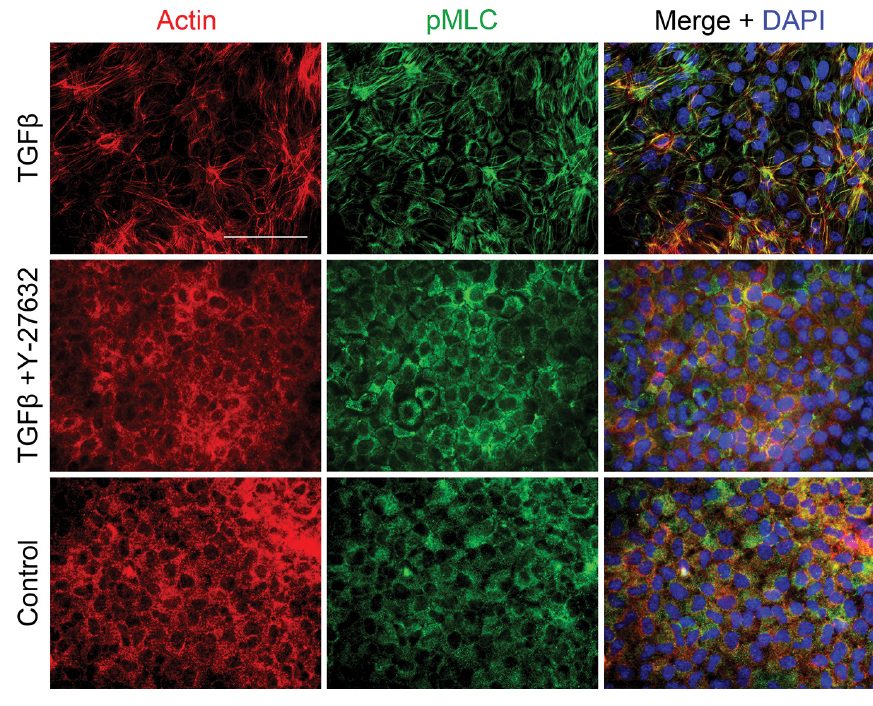
Figure 1. Y-27632 prevents TGF β -induced actomyosin contractility. Lens explants were treated with TGF β (4 ng/mL) in the presence and absence of Y-27632 (20 μ M) for 48 h. Fixed explants were costained for pan-actin and phosphorylated myosin light chain (pMLC), and mounted in medium with DAPI to colocalize nuclei. Scale bar = 100 μ